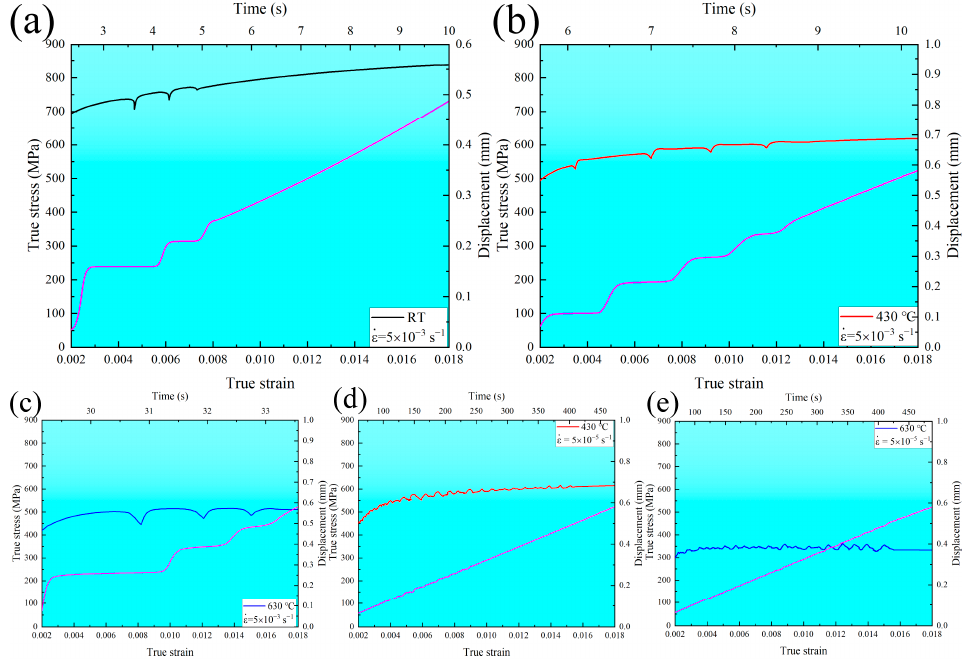
Figure 2. True stress–true strain curves and displacement vs. time (purple line) for MarBN steel of strain rate of 5 × 10 − 3 s − 1 at ( a ) RT, ( b ) 430 °C, ( c ) 630 °C; and 5 × 10 − 5 s − 1 at ( d ) 430 °C, ( e ) 630 °C. 3.1.2. Work-Hardening Parameters Dependent on the Strain Rate and Temperature The work-hardening region starts as the strain increases beyond the yield strength point and ends at the ultimate strength point during the uniaxial tensile stress–strain curve, which is associated with the dislocation generation, accumulation, and multiplica- tion along with the grain boundaries. According to Figure 1, the work-hardening rate vs. true plastic strain under different temperatures at the strain rates of 5 × 10 − 3 s − 1 and 5 × 10 − 5 s − 1 are plotted, respectively, as shown in Figure 3. In contrast, the work-hardening rate decreases with increasing the true plastic strain up to about 0.06. The serration behavior under RT and 430 °C at a strain rate of 5 × 10 − 3 s − 1 is present along with the work-hardening rate curves. The same is found under 430 and 630 °C at a strain rate of 5 × 10 − 5 s − 1 . These phenomena indicate that work hardenability is sensitive to strain rate and temperature.